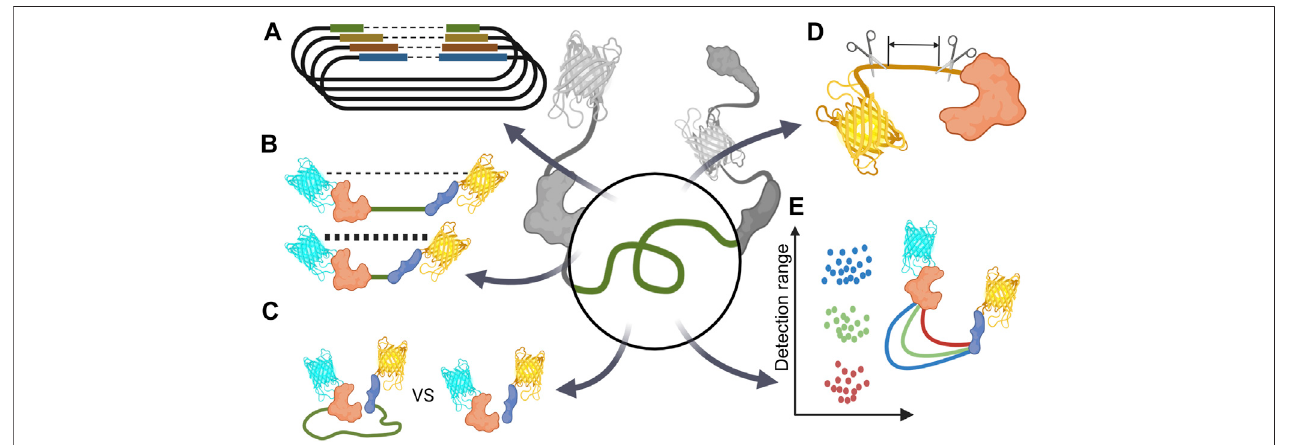
FIGURE 4 | Schematic diagram of linker optimization strategy (A) Optimize linker length via vector library. (B) Minimize basal FRET signal by extend linker (C) Comparing unimolecular and bimolecular biosensors. (D) Reducing unintentional linker-like peptides such as protein terminal parts or short peptide originated from restriction enzyme DNA sequence. (E) Changing sensor detection range via linker optimization.